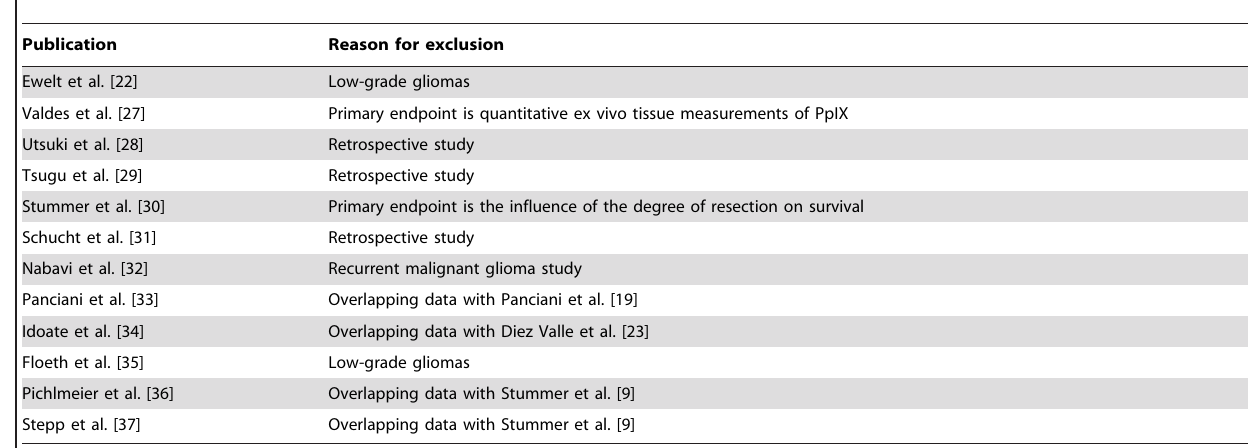
Table 1. Exclusion of clinical trials and reasons for